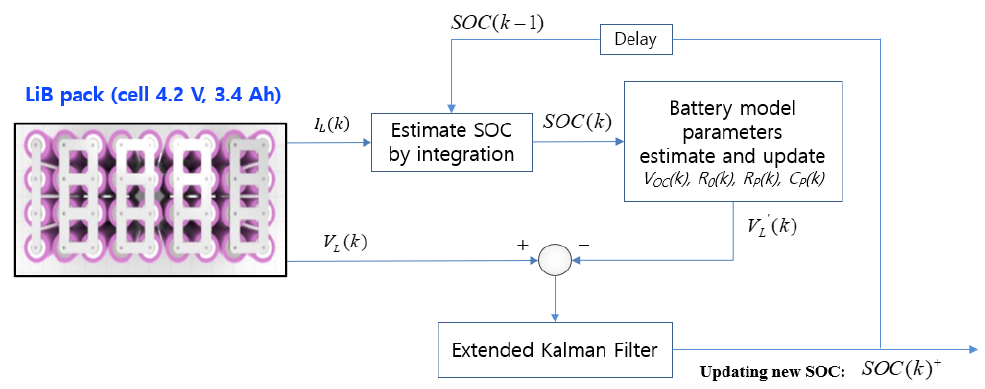
Figure 10. Diagram of the SOC estimation method based on the EKF.